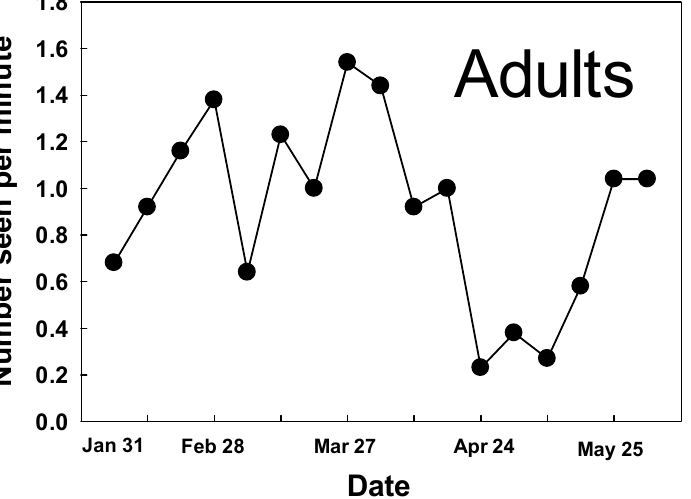
Figure 4. Monarch adults recorded during weekly surveys at Googleplex, Mountain View, CA, USA, 31 January–31 May 2021. Table 1. Nectar plants used by monarchs at Googleplex and blooming periods. Plant Species